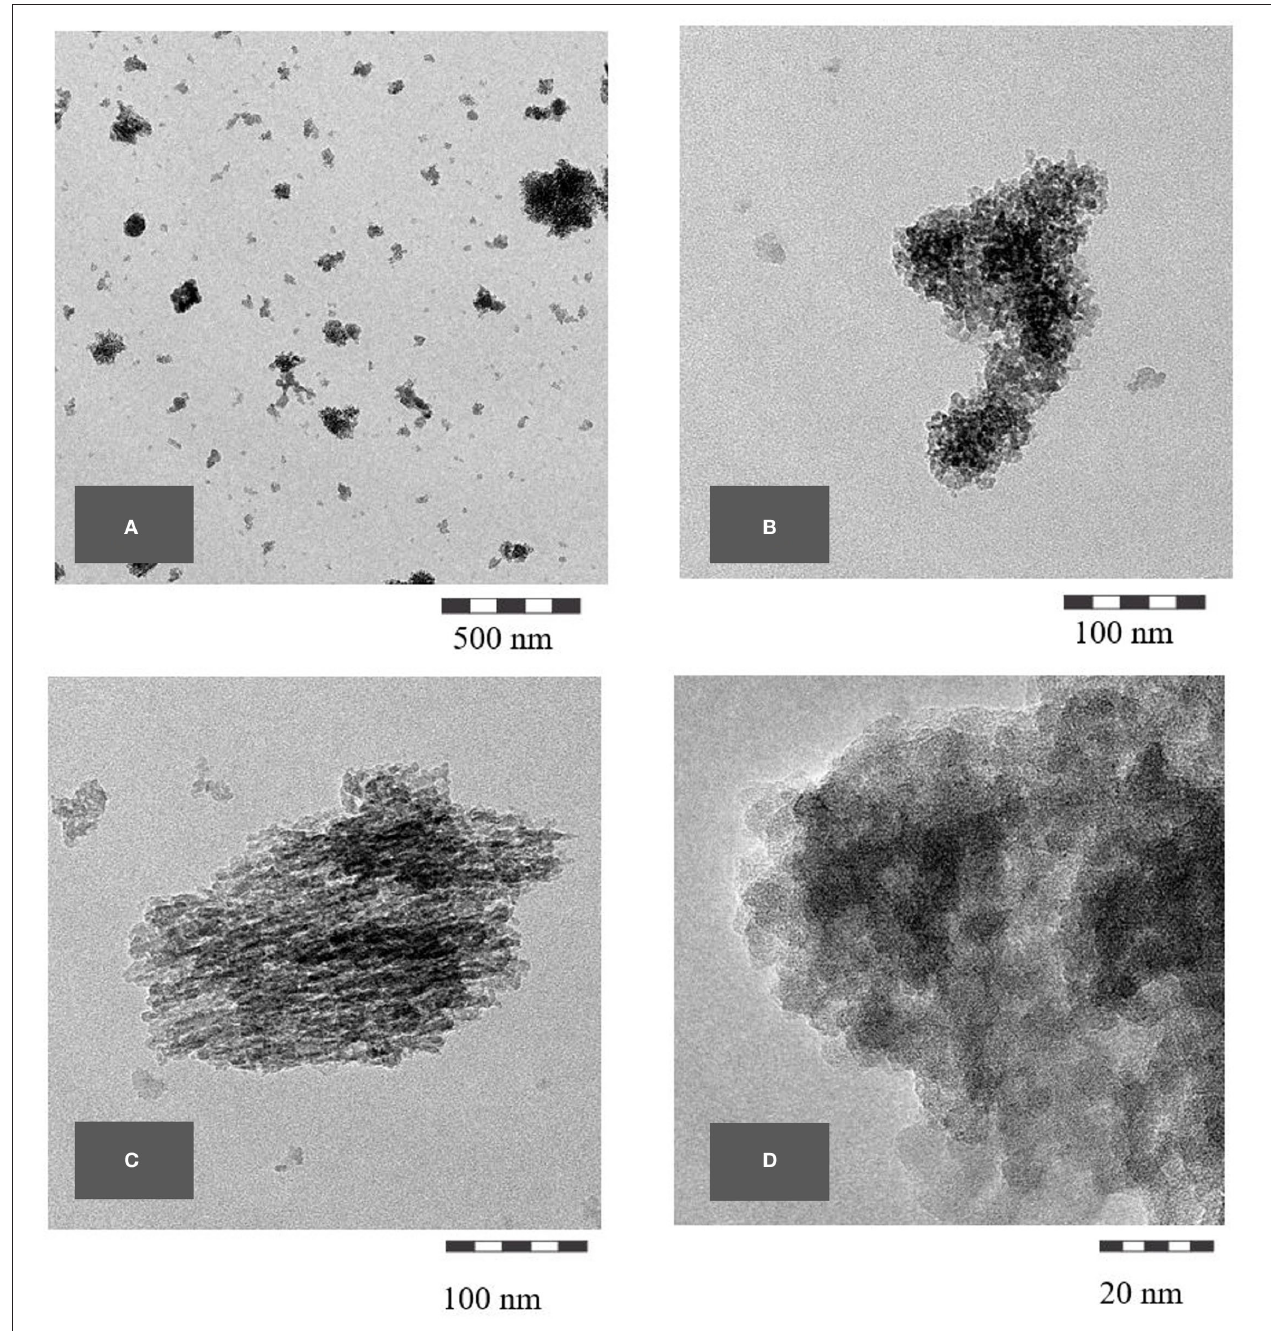
FIGURE 6 | (A–D) TEM micrographs of common horsetail final